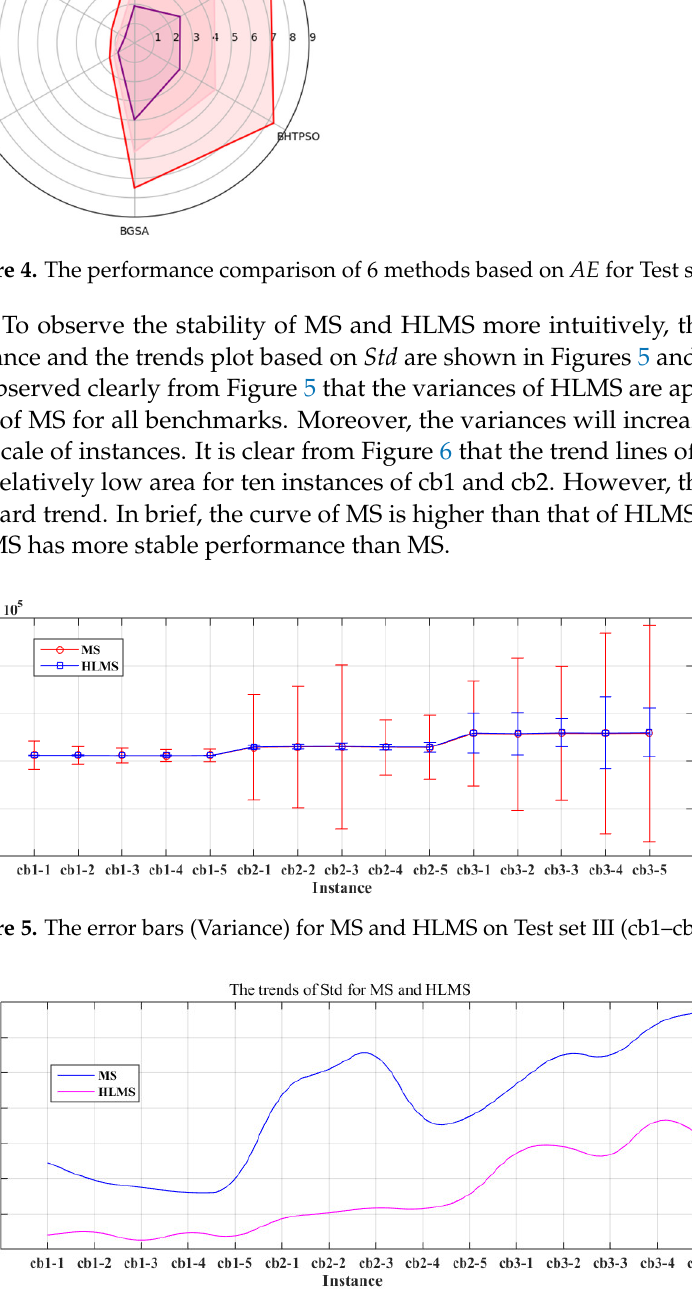
Figure 6. The trends of Std for MS and HLMS on Test set III (cb1–cb3).